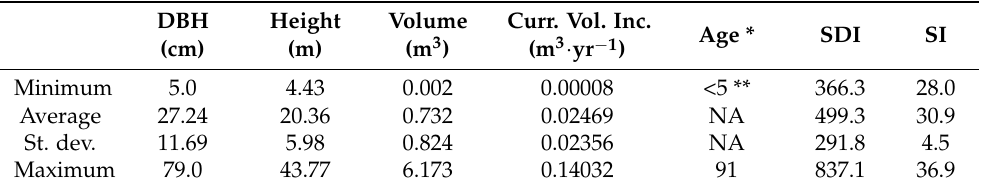
Table 1. Summary statistics of the main mensurational parameters derived from INFC 2005 and literature data for Pseudotsuga menziesii in Italy. Due to the lack of information concerning the age of the trees in the National Forest Inventory dataset, this information was mainly recovered from literature data and estimated for the minimum value since the presence of small trees measured suggests successful regeneration